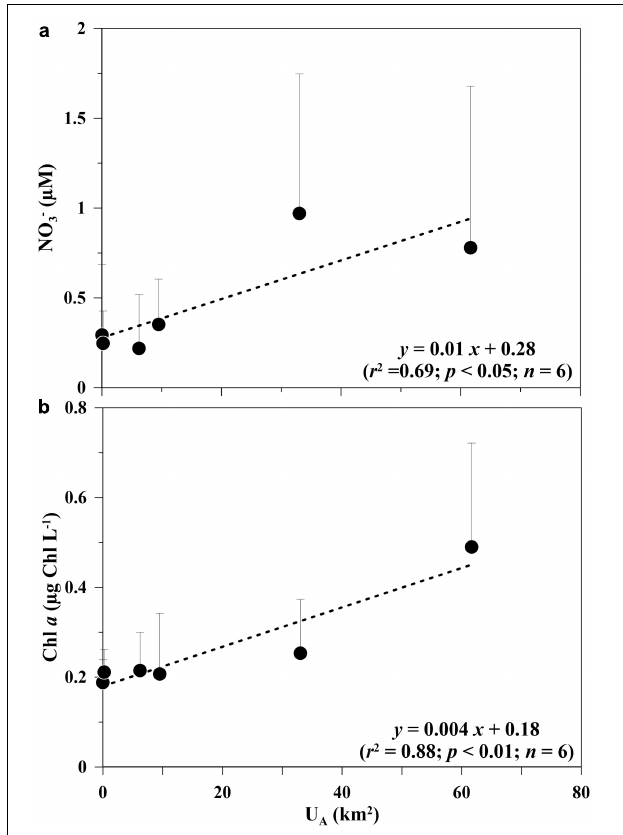
FIGURE 4 | Relationships between the uplift area ( U A ; km 2 ) versus the mean depth-integrated values of (a) nitrate (NO 3 − ; µ M) and (b) chlorophyll a (Chl a ; µ g Chl L − 1 ) over each sampling period. SD (vertical lines with caps) is also illustrated and applied to Figure 8